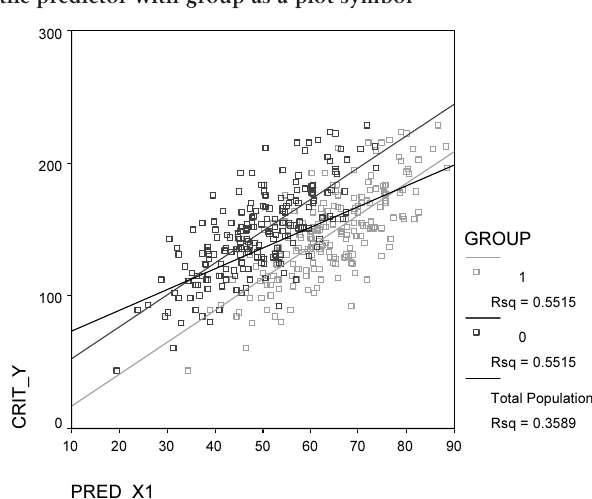
Figure 1: Scatter plot of the unstandardised residuals against the predictor with group as a plot symbol